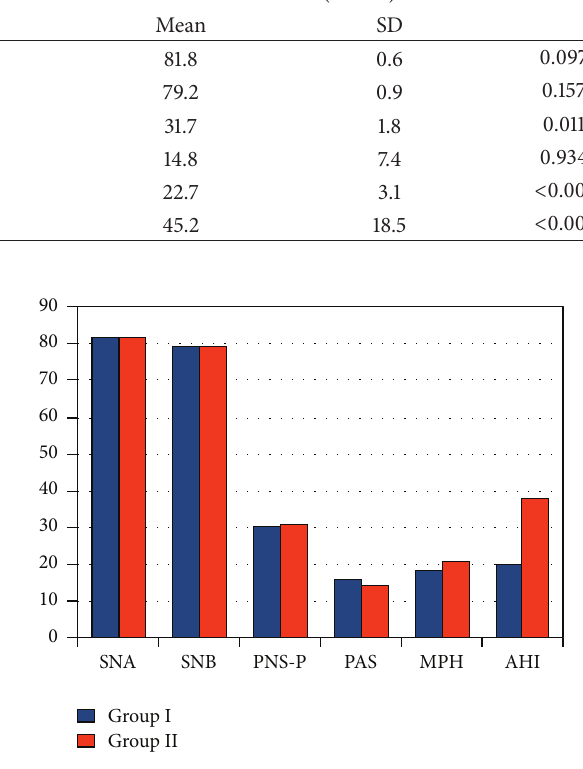
Figure 2: Bar diagram lateral cephalometric variables with retropalatal